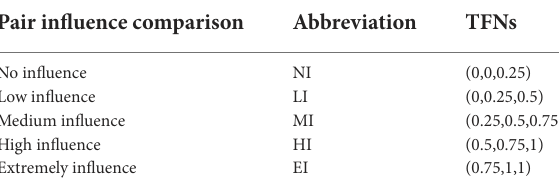
TABLE 3 Linguistic variable for the pairwise influence degree of criteria (component A of Z-number).